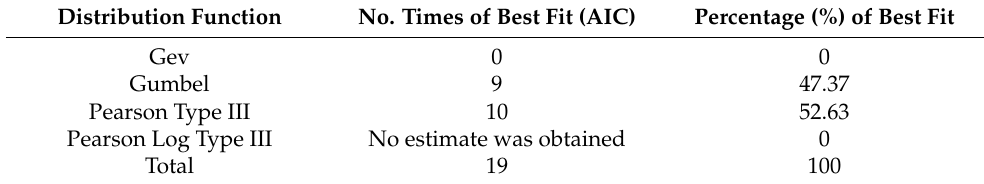
Table 4. Best fit distribution